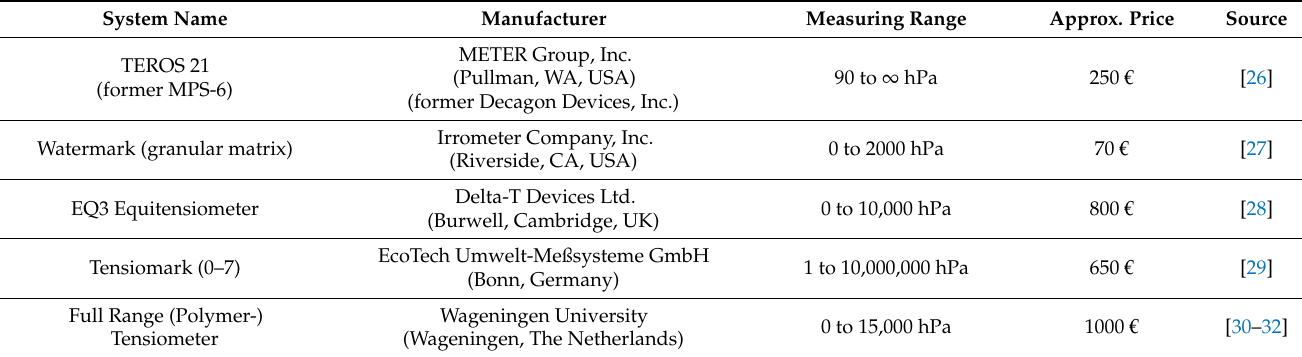
Table 1. Commercially available sensor systems. All information according to the respective